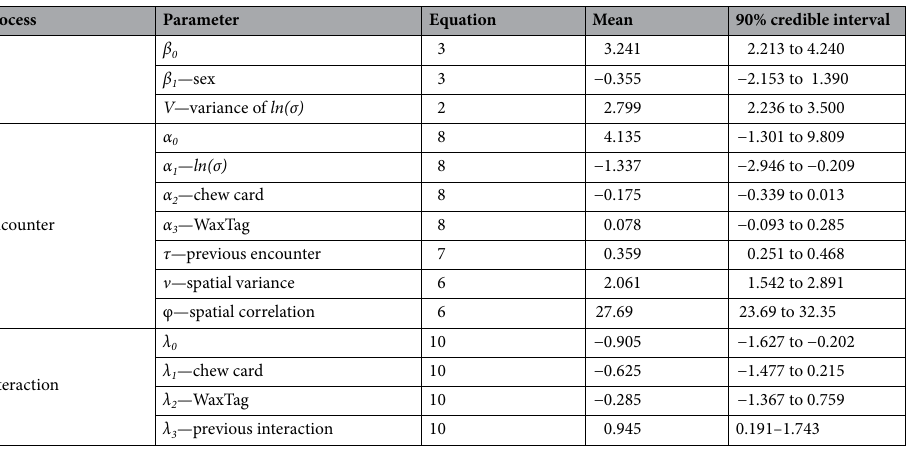
Table 1. Means and 90% credible intervals for parameter estimates derived from a Bayesian model of ship rat ( Rattus rattus ) encounter and interaction probabilities with three types of devices (bait stations, chew cards, WaxTags) in Wellington city, New Zealand. Bait stations are the default device modelled via parameter α 0 for the process of encountering a device, and in parameter λ 0 for the process of interacting with a device. See “Data analysis” section for a detailed description of each parameter or refer to the equation number where each parameter is used